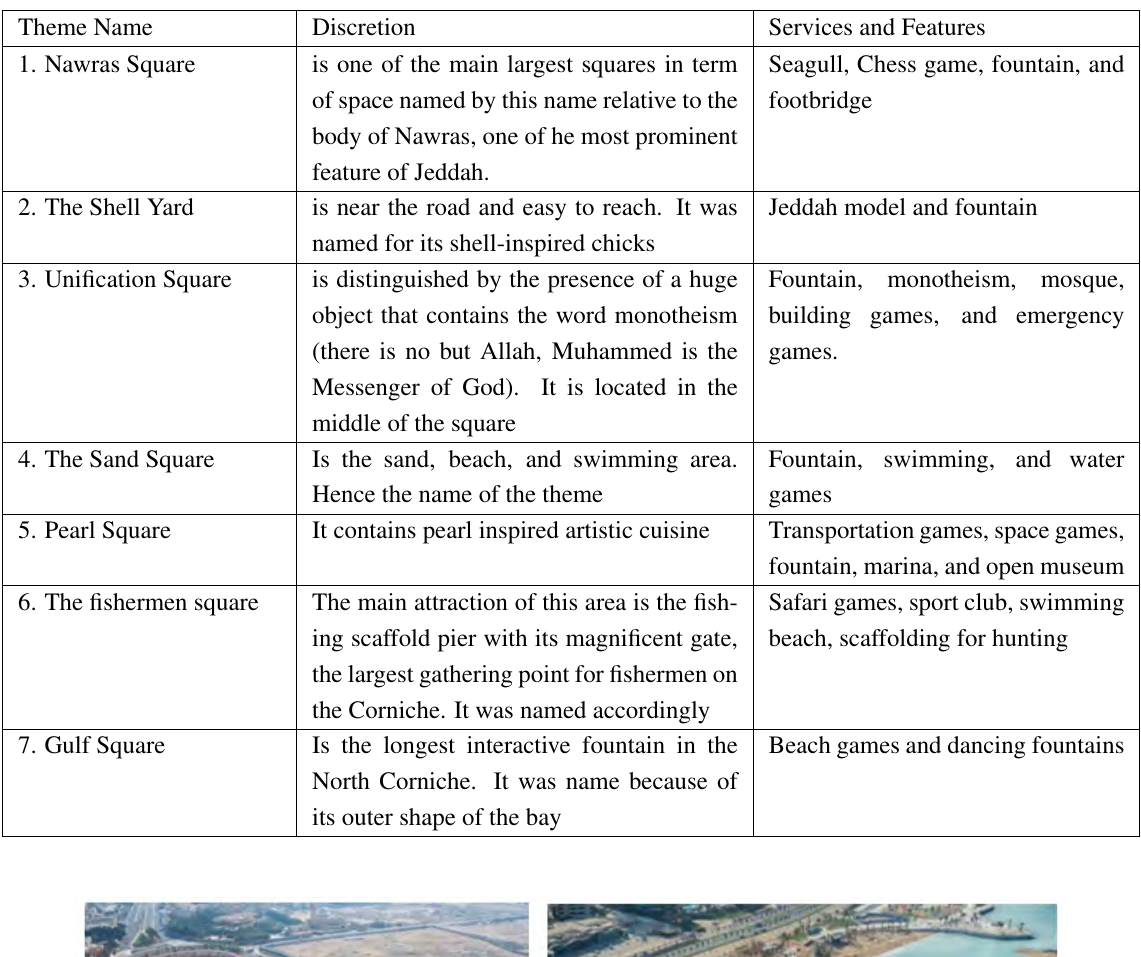
Table 1. The NJW Seven ThemeParks. Source: authors